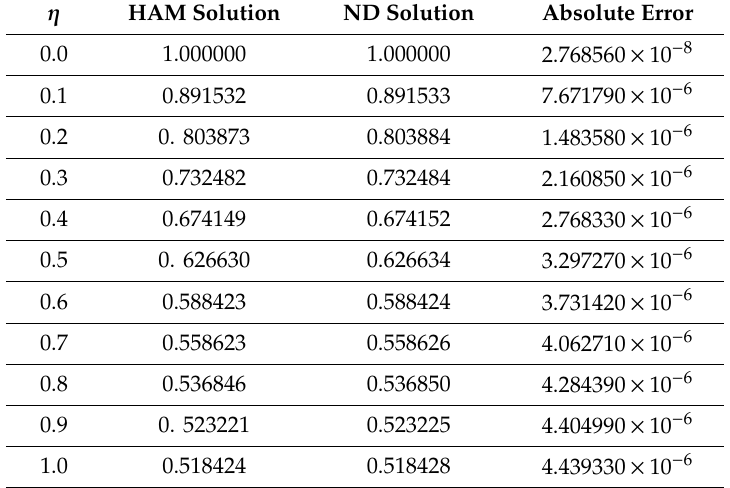
Table 4. Comparison of HAM and ND-Solve for temperature function θ ( η ) w.r.t. di ff erent values of the dimensionless variable η .